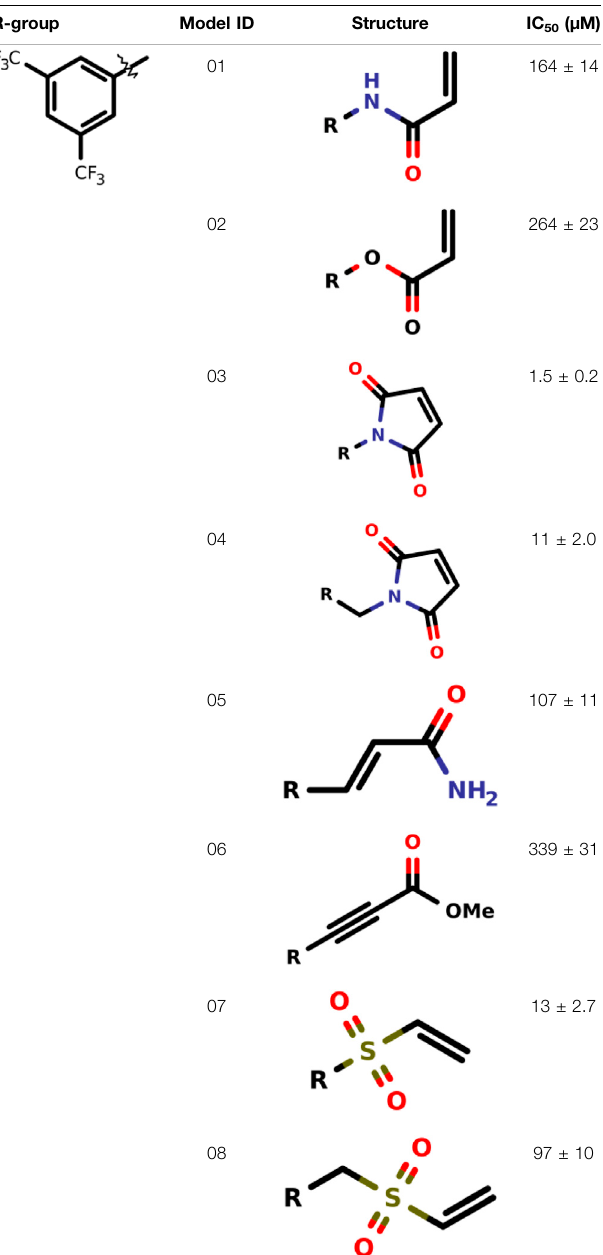
TABLE 2 | Michael-type nucleophilic addition in main covalent fragments by Petri et al., 2021. Michael-type nucleophilic addition in main covalent fragments